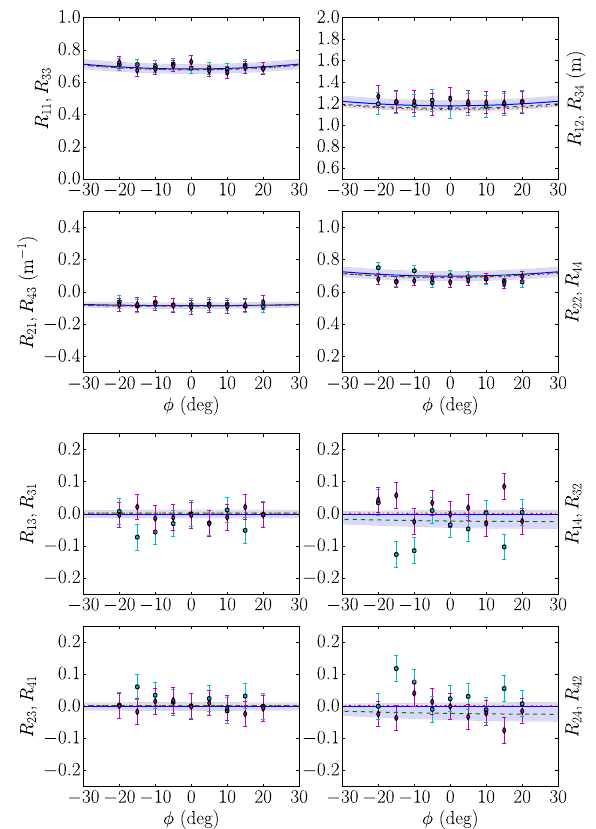
FIG. 5. Diagonal (top four plots) and antidiagonal (bottom four plots) blocks of the transport matrix. The solid (blue) lines represent Chambers ’ approximation, dashed (green/red) lines are obtained from 3D field map simulations for ð x; x 0 Þ and ð y; y 0 Þ planes respectively, circular markers and purple lozenges corre- spond to experimental values for ð x; x 0 Þ and ð y; y 0 Þ planes respectively. Shaded area represents matrix element variation due to rf calibration uncertainties